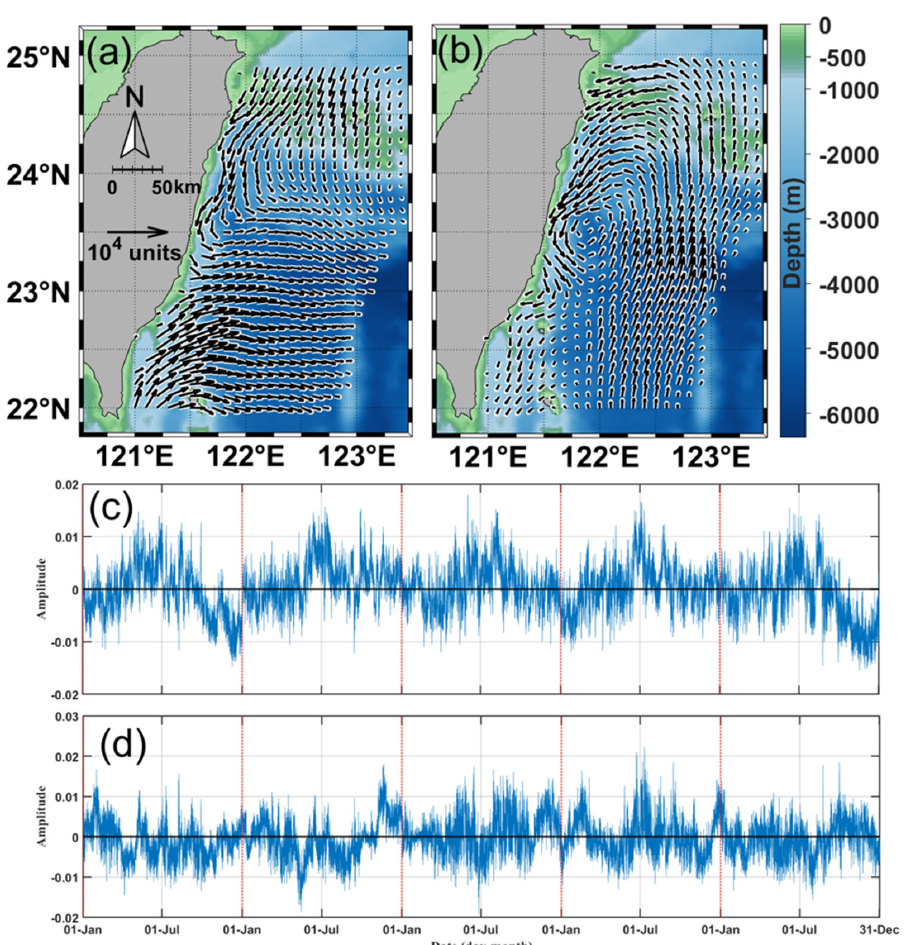
Figure 9. EOF results of 5-year data. Spatial pattern of ( a ) mode 2, ( b ) mode 3, and corresponding time series of principal components of ( c ) mode 2, ( d ) mode 3.